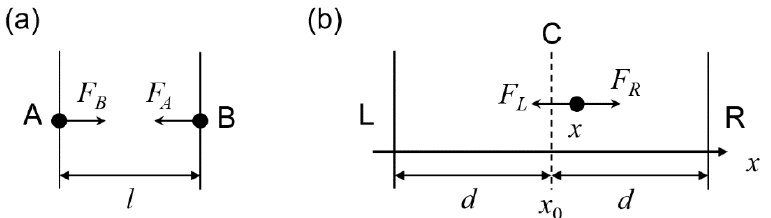
Figure 2. Mechanical loadings in oxDNA simulations. ( a ) Hypothetical linear spring forces between two nucleotide A and B (solid dots) with a distance l . The forces on A pointing to B is denoted as force F B , and similar naming applies to F A . A set of spring forces was used for cyclization of the DNA origami tile. ( b ) Hypothetical linear spring forces pulling a nucleotide (solid dot) at x to an imaginary plane (dashed line, marked as C) located at x 0 . The forces are realized by two planes, L and R (vertical lines), in a distance d from the imaginary plane on the left and right sides. The force toward the left plane (L) is F L , whereas the force toward the right plane (R) is F R